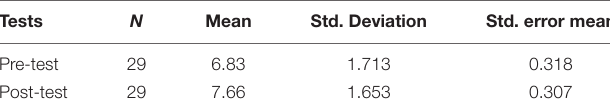
TABLE 11 | Pair samples statistics of the experimental